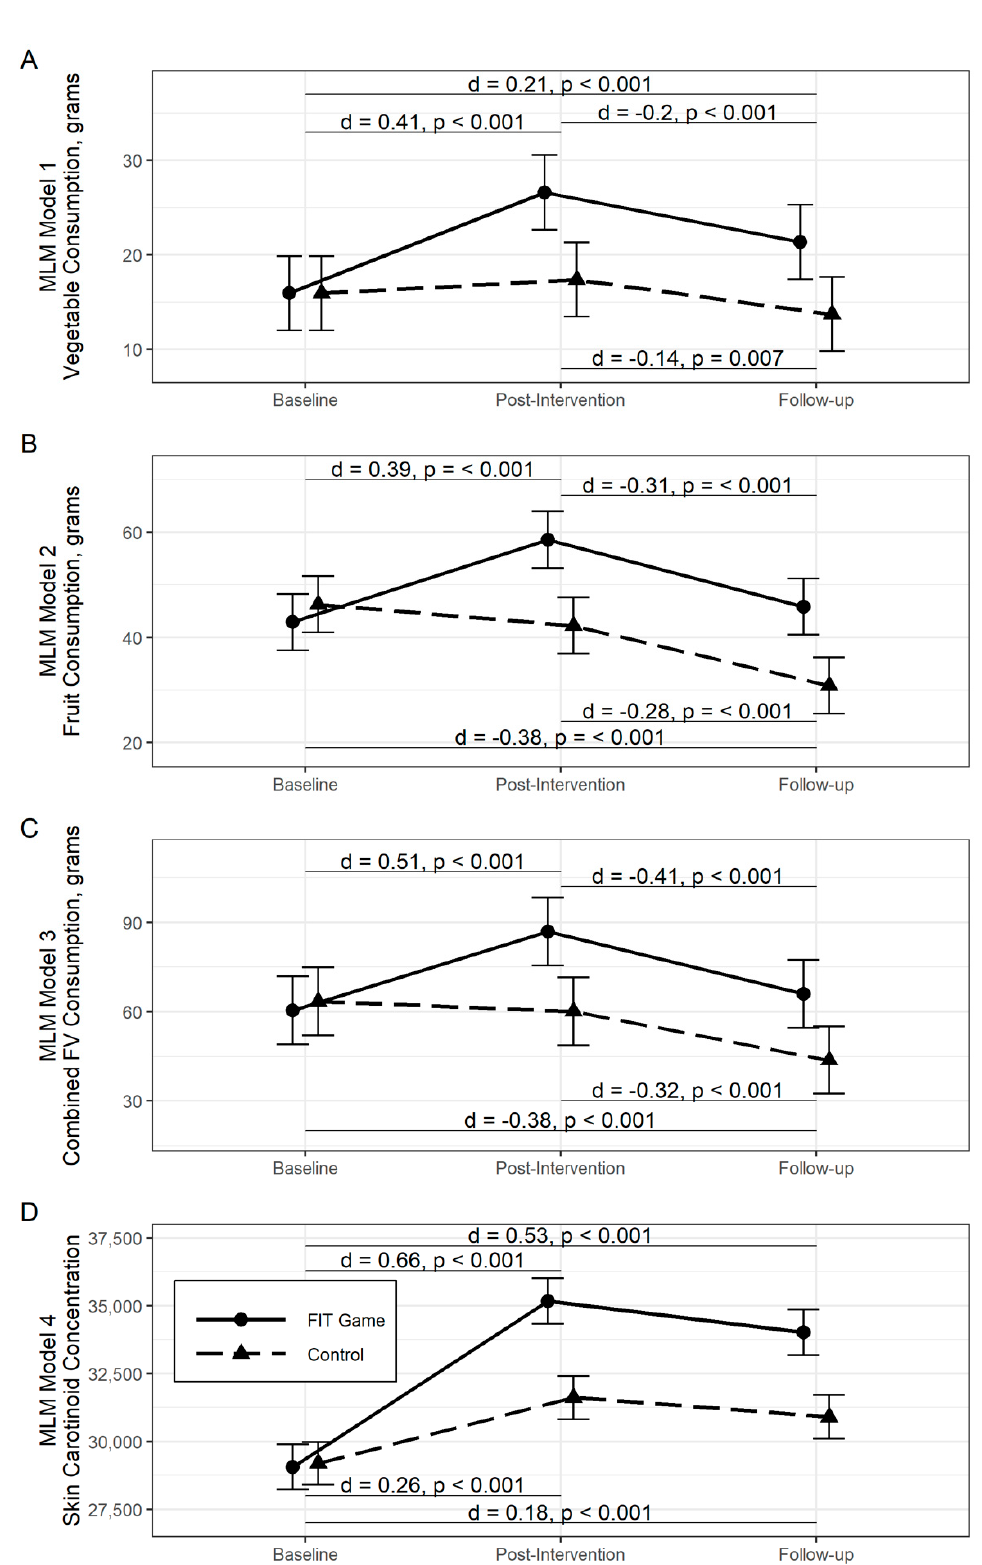
Figure 3. Estimated marginal mean ( ± SEM) for separate multilevel models (MLM) for consumption (in grams) of vegetables, fruit, and combined fruit and vegetable (FV), as well as skin carotenoid levels in FIT Game and Control schools across the three phases of the experiment. Significant ( α = 0.05, Tukey’s HSD) within-group differences are indicated with Cohen’s d-like standardized mean difference (SMD) effect sizes.